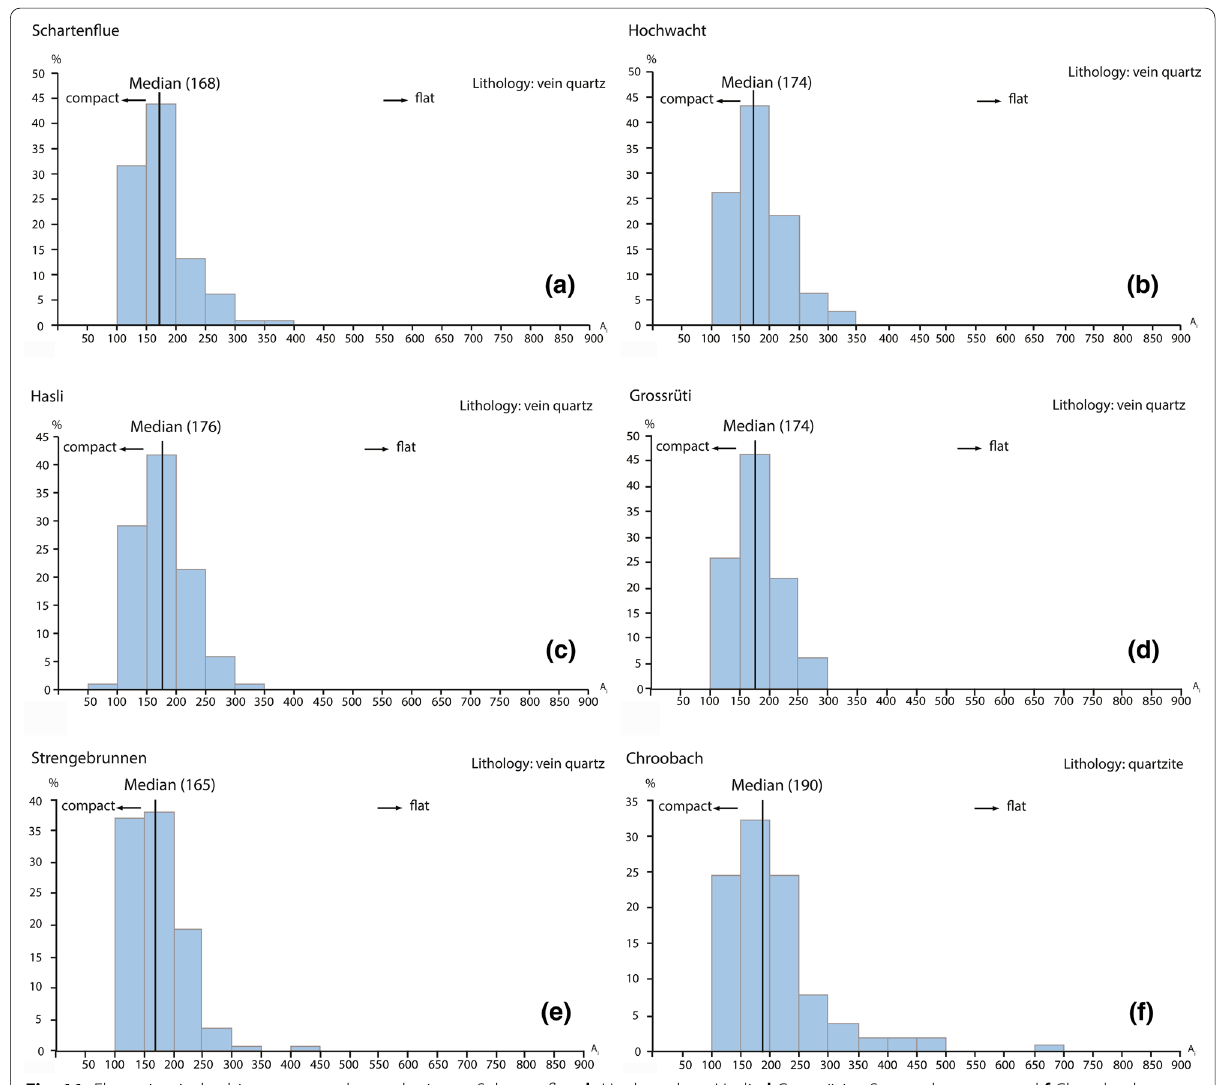
Fig. 11 Flattening index histograms at the study sites: a Schartenflue; b Hochwacht; c Hasli; d Grossrüti; e Strengebrunnen; and f